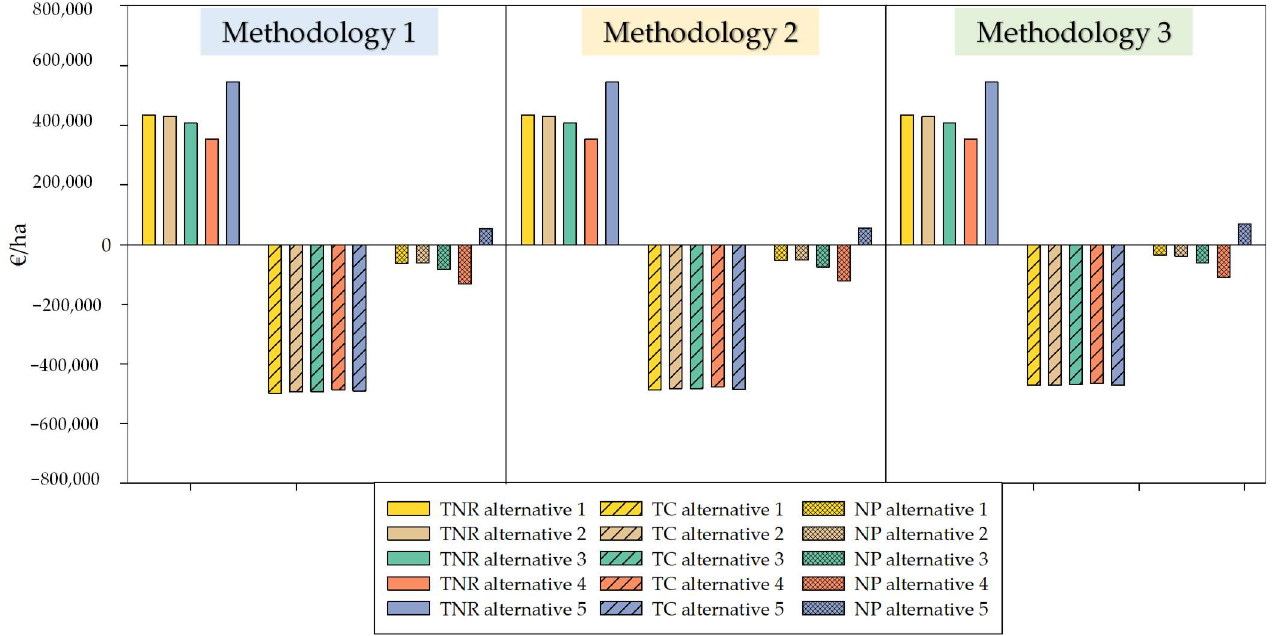
Methodology 1: conventional; Methodology 2 : self-management of plant debris and reduction in water, soil management, and chemical soil disinfectants; Methodology 3: Methodology 2 + reduc- tion of inorganic fertilization. Source: own elaboration based on Torresano and Camacho-Ferre [47], Honore et al. [2], Junta de Andalucia [48], Torres-Nieto [49], and specialized agricultural sup- ply centers.